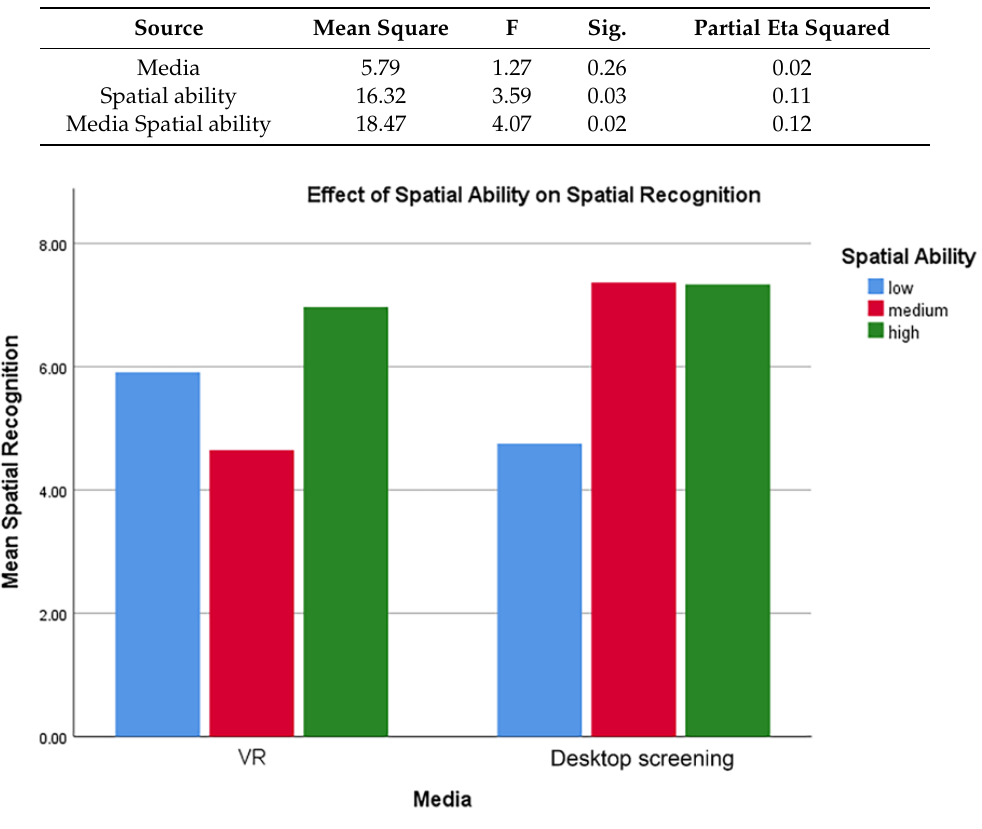
Figure 9. Frequency of each level of media within three spatial ability categories affected by the spatial recognition score. recognition